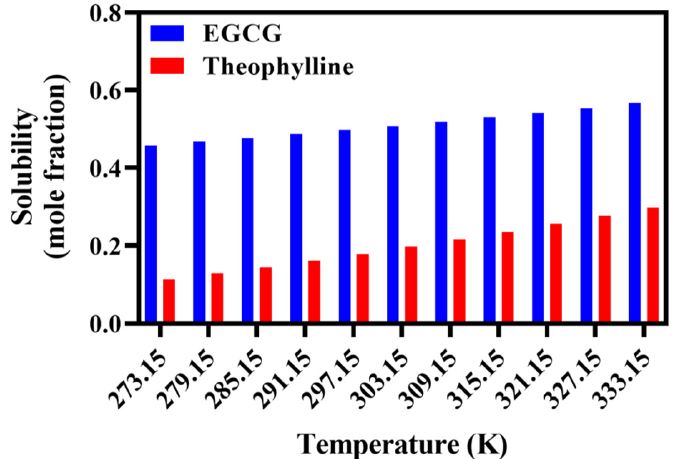
Figure 10. Solubility of various substances in ILs at different temperatures.